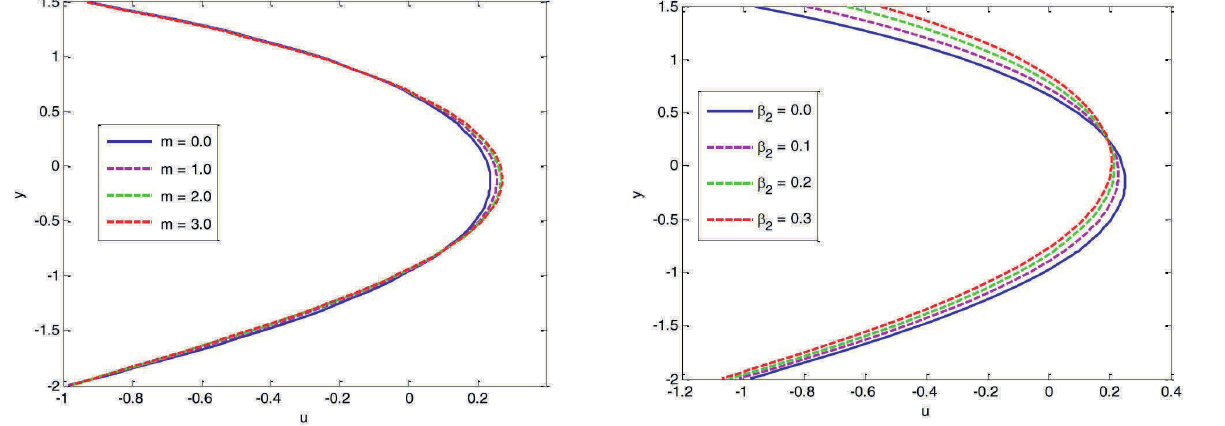
Fig. 6: Impact of Hall parameter m on velocity.